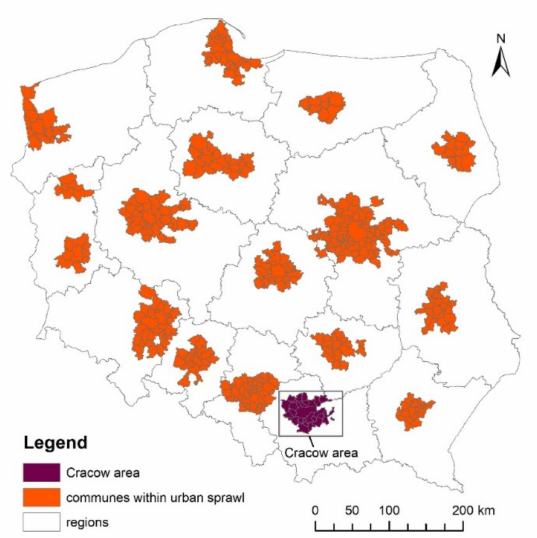
Figure 1. Research area: Cracow and surrounding communes within urban sprawl, Poland. Source: own based on Lity´nski and Hołuj